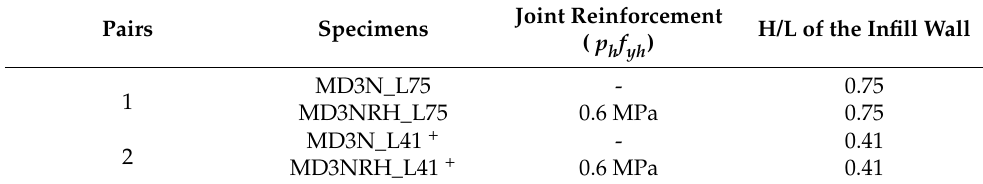
Table 1. Description of the